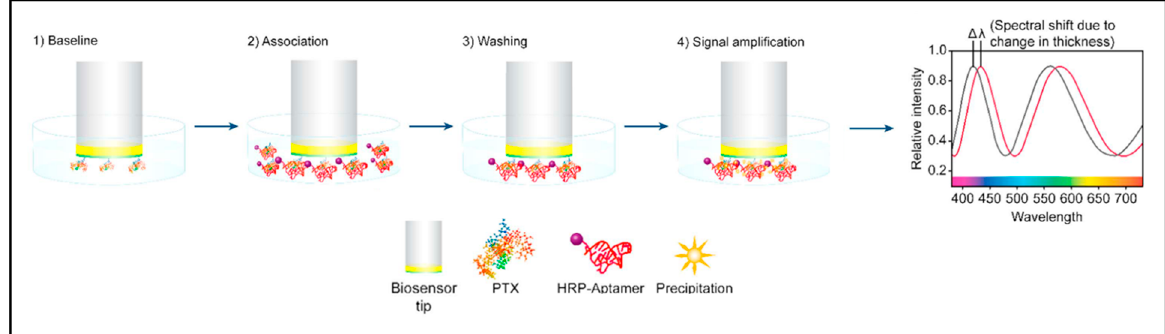
Figure 5. Schematic representation of a competitive biolayer interferometric biosensor for palytoxin (PTX) detection using HRP-labeled aptamers as biorecognition receptors. (Reproduced with permission [123] Copyright 2017, Elsevier).